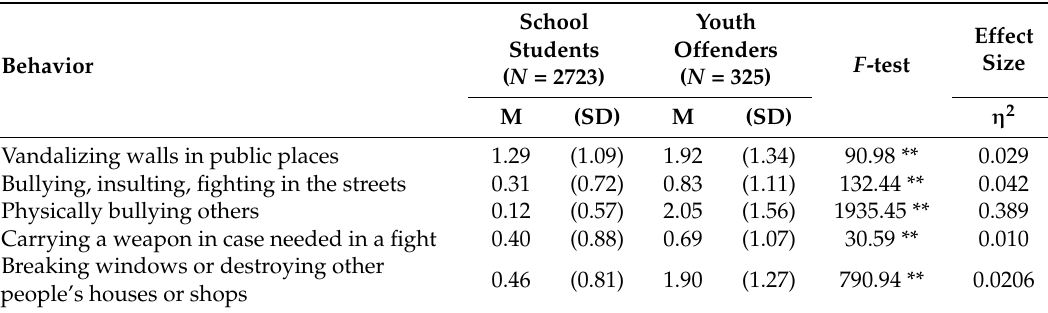
Table 3. Violent behaviors of school students and youth